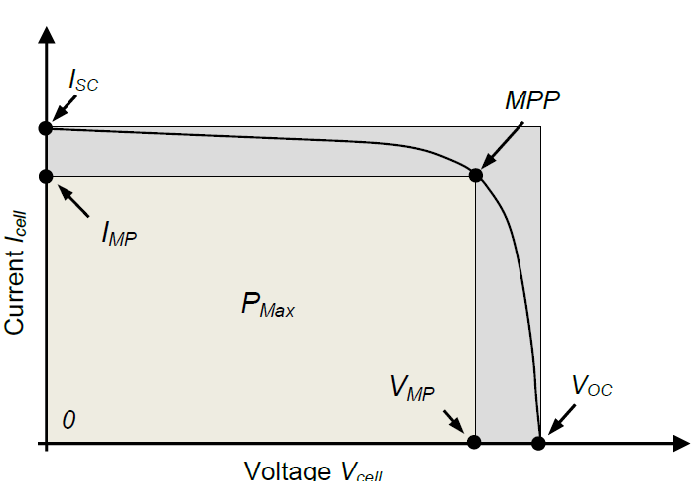
Figure 2. Typical I–V characteristics of a PV cell with marked characteristic Figure 2. Typical I – V characteristics of a PV cell with marked characteristic points.